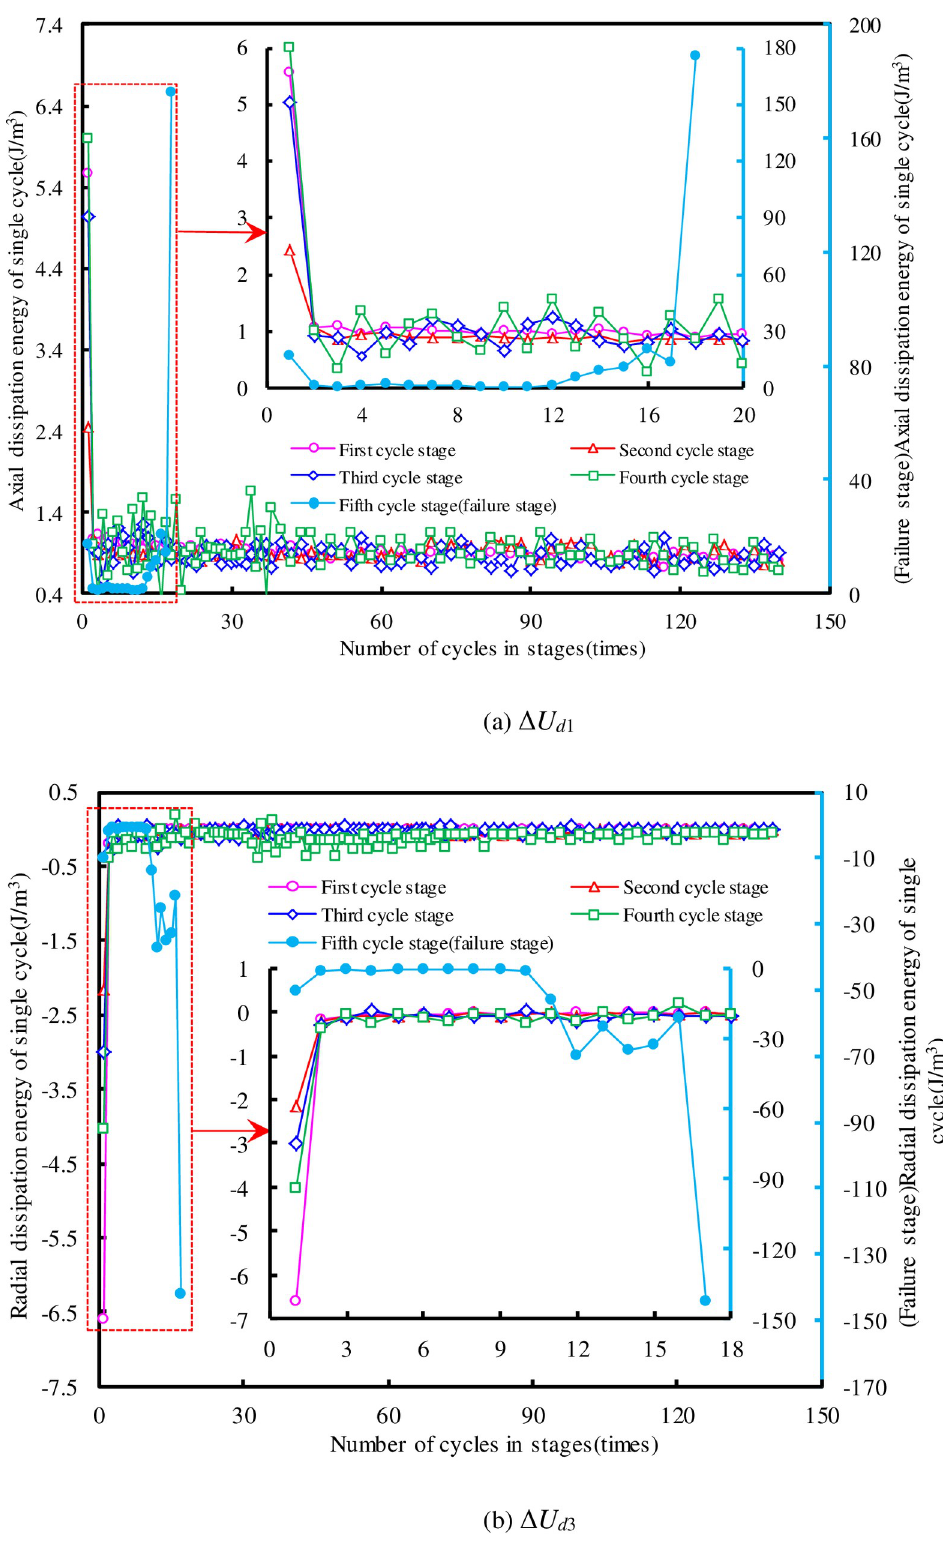
Fig 9. The curve of Δ U d in the SS-2 at different cycle stages.